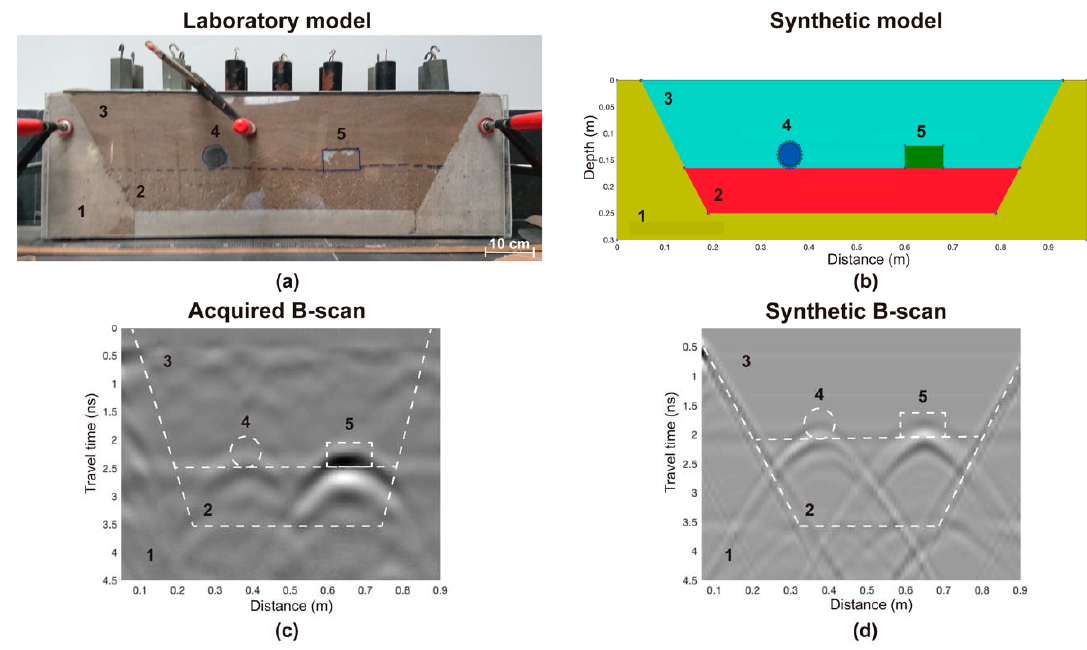
Figure 1. ( a ) Model created in the laboratory using soil from an archaeological site in which objects were buried are: 1— cement slopes and base; 2—soil, layer 1; 3—soil, layer 2; 4—hollow plastic cylinder; 5—solid aluminum prism. ( b ) Synthetic model. ( c ) Acquired B-scan. ( d ) Synthetic B-scan. The B-scans are similar in terms of the object reflections. The differences lie in the background noise present in the acquired data.